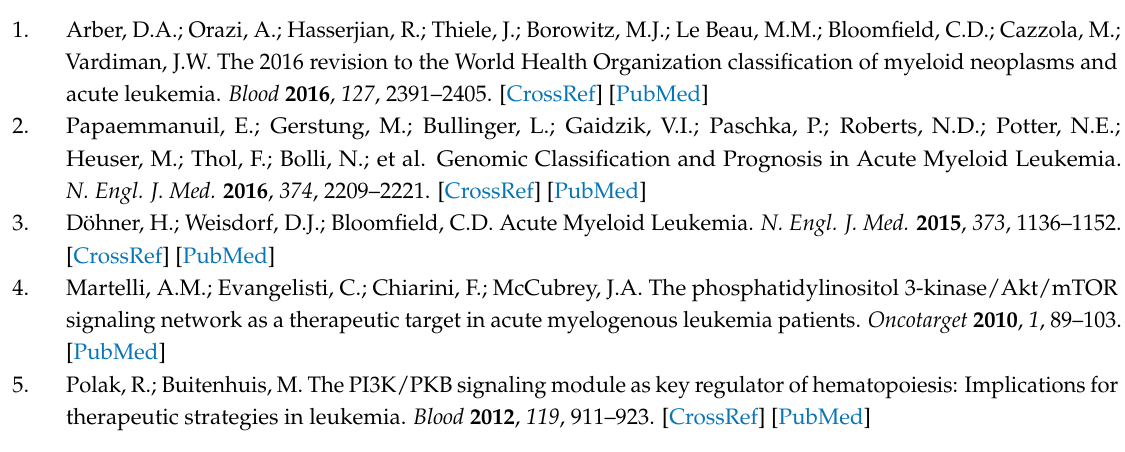
Figure S1: Detection of clonal heterogeneity for 49 AML patients; Figure S2. Cell preparation and gating strategy; Figure S3. A correlation visualization with distance matrix; Table S1. A comparison of patients with and without dual AML cell populations; studies of molecular genetics, differentiation and pathway activation profiles; Table S2. The GO-term showing significant differences when comparing AML cell populations for patients with and without clonal heterogeneity; the comparison being based on analysis of Molecular function; Table S3. The GO-term showing significant differences when comparing AML cell populations for patients with and without clonal heterogeneity; Table S4. Monoclonal antibodies used in the flow-cytometric studies; Table S5. The complete gene list from patients with dual AML cell populations; Table S6. The complete gene list from patients without dual AML cell